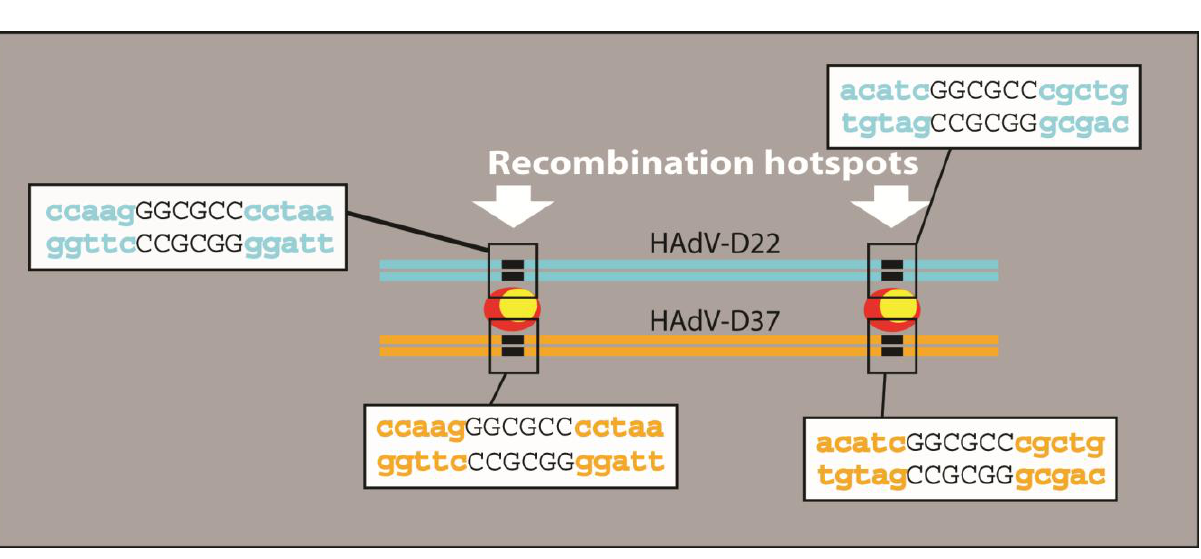
Figure 4. Hypothetical recognition sites for recombination in the hexon gene. Rectangular boxes represent hypothesized recognition sites, which are recognized by hypothetical recombinase. Red and yellow ovals are hypothesized recombinase